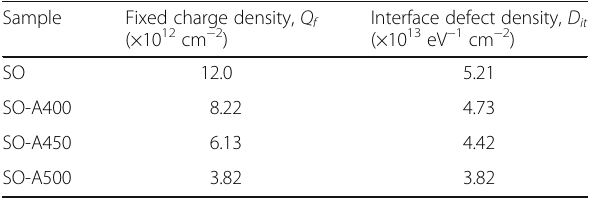
Table 2 Calculated fixed charge density ( Q f ) and interface defect density ( D it ) from C-V measurement of the HfO 2 thin films Sample Fixed charge density, Q f (×10 12 cm − 2 )